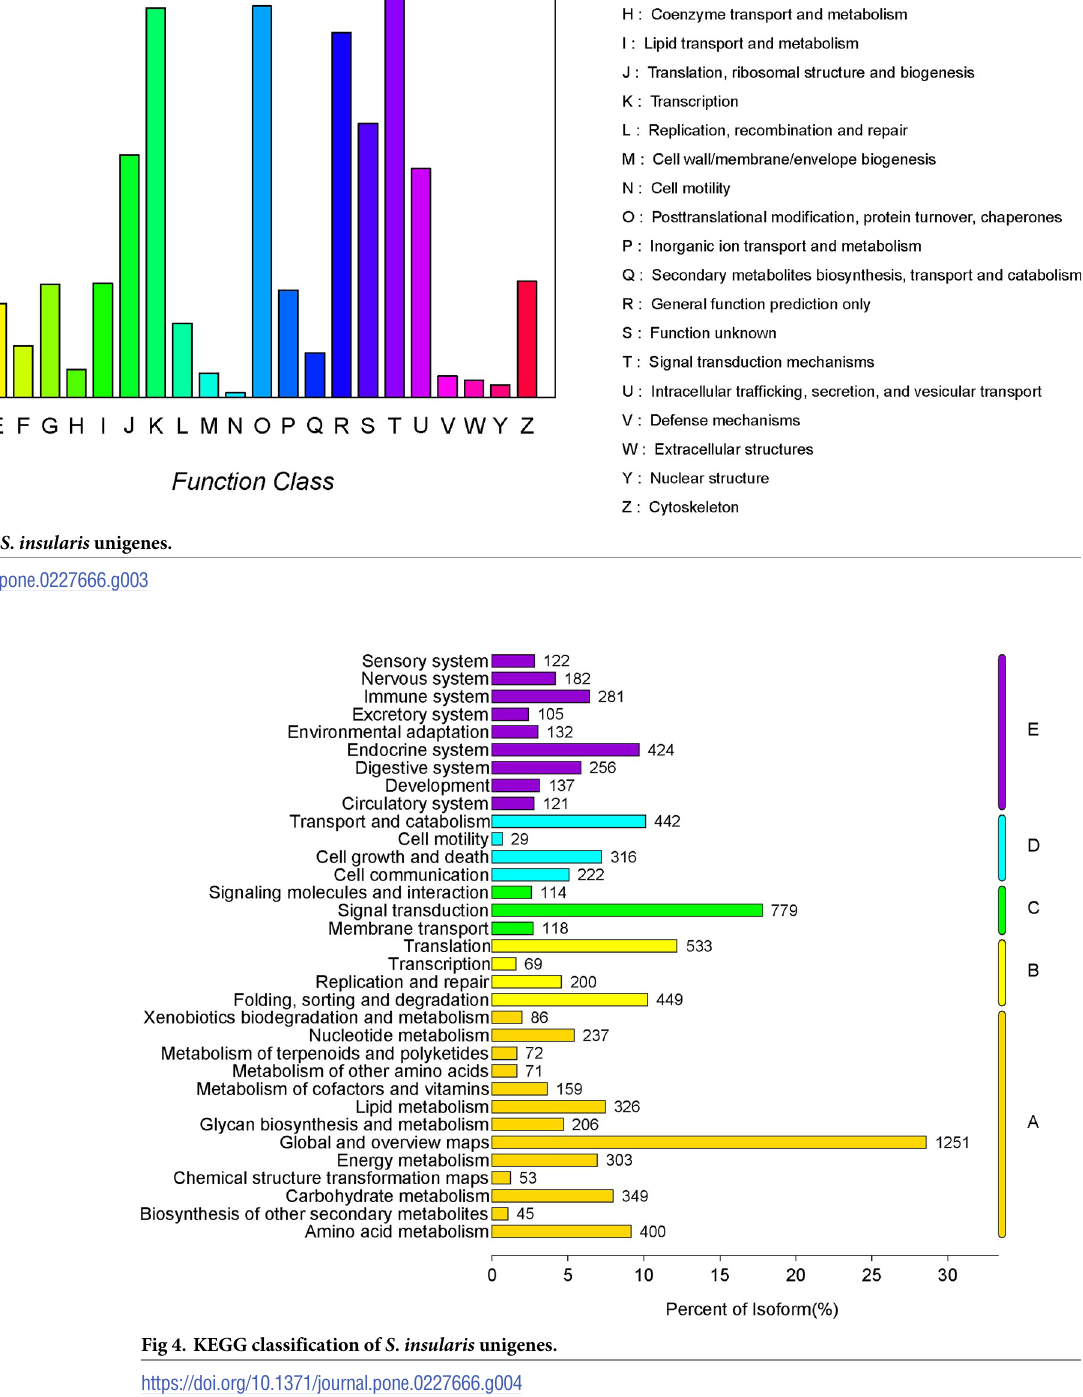
PLOS ONE | https://doi.org/10.1371/journal.pone.0227666 January 16,